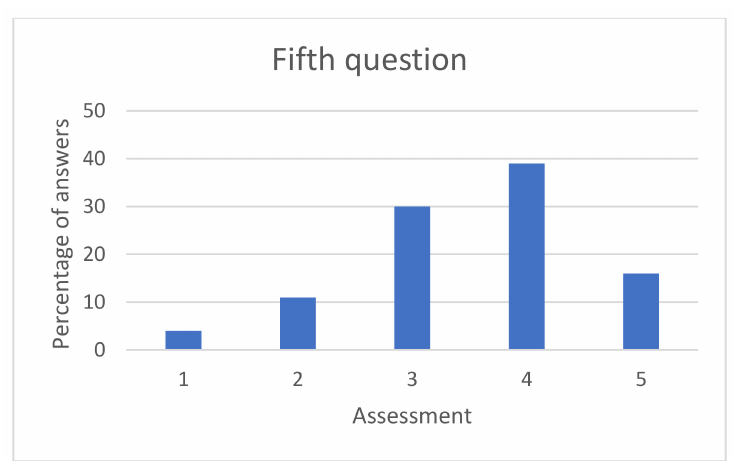
Figure A6. Results of question 5.